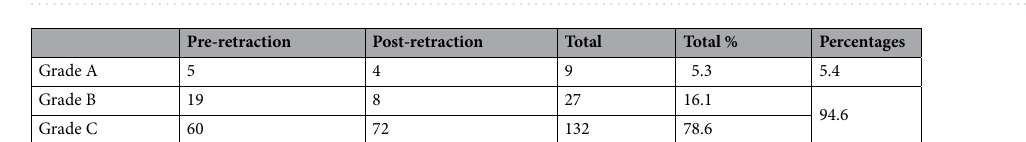
Figure 5. Examples of CRCR Grade C.